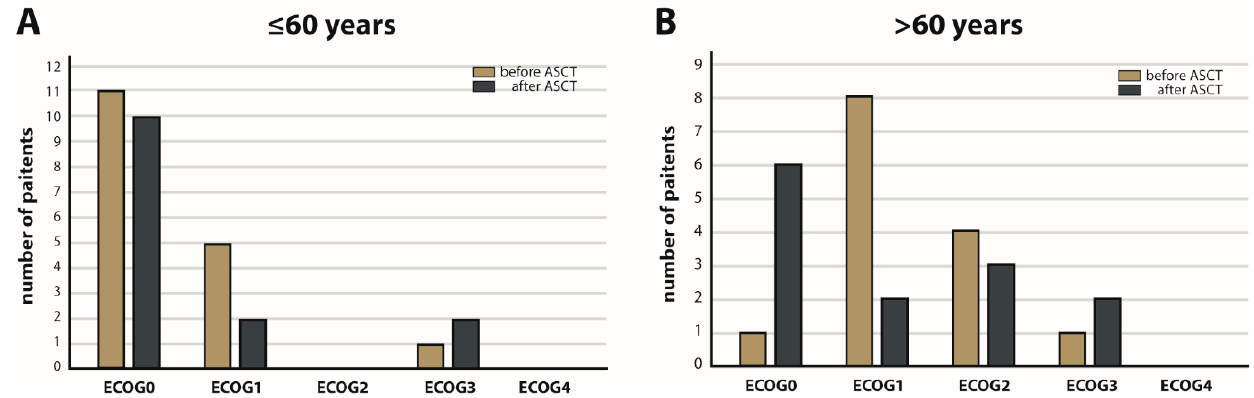
Figure 3. ECOG performance status (PS) before and after high-dose chemotherapy followed by au- tologous stem cell transplantation (HDC/ASCT). X-axis: ECOG PS grade 0–4. Y-axis: number of pa- tients. ( A ): Group ≤ 60 years ( p = 0.414). ( B ): Group > 60 years ( p = 0.449).